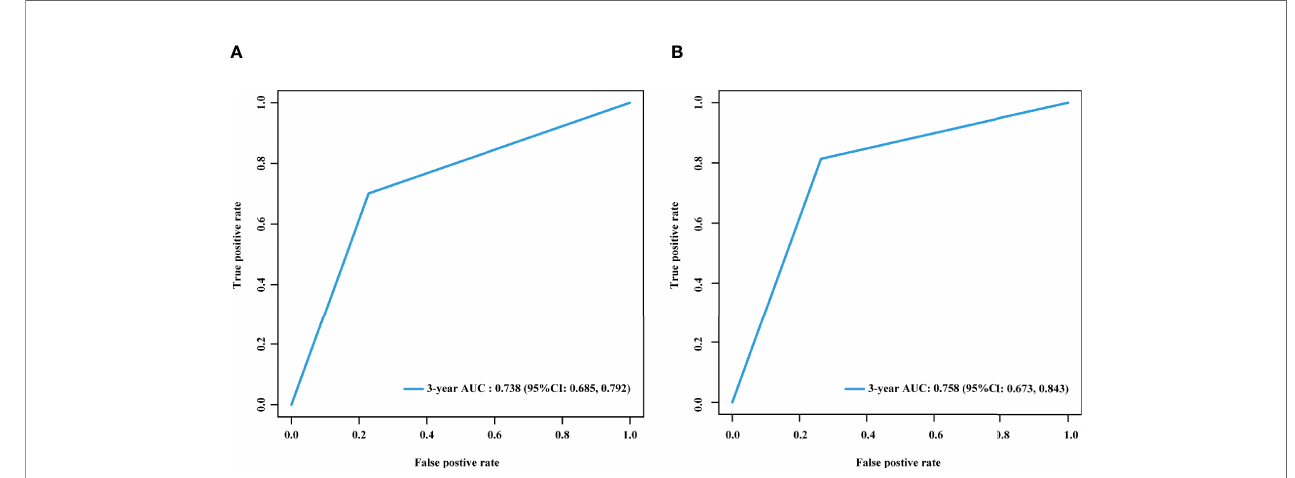
FIGURE 6 | Time-dependent ROC curves of the LM risk score in the training and validation cohorts. Time-dependent ROC curves of the LM risk score in the training (A) and validation (B) cohorts at 3 years. AUC, area under the ROC curve; ROC, receiver operating characteristic; LM, liver metastasis; CI, con fi dence